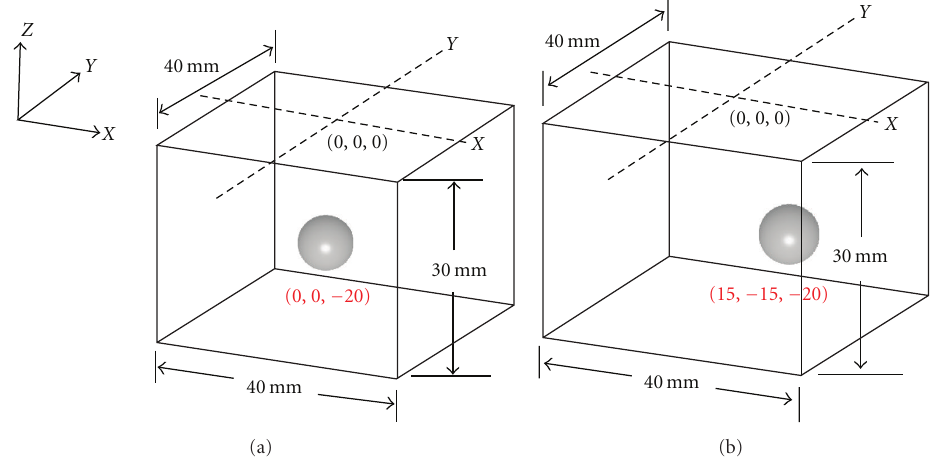
Figure 6: Schematic diagram of setups used in simulation study. (a) Setup I: the inclusion was located right below the center of measurement plane. (b) Setup II: the inclusion was located close to the right side corner of the measurement